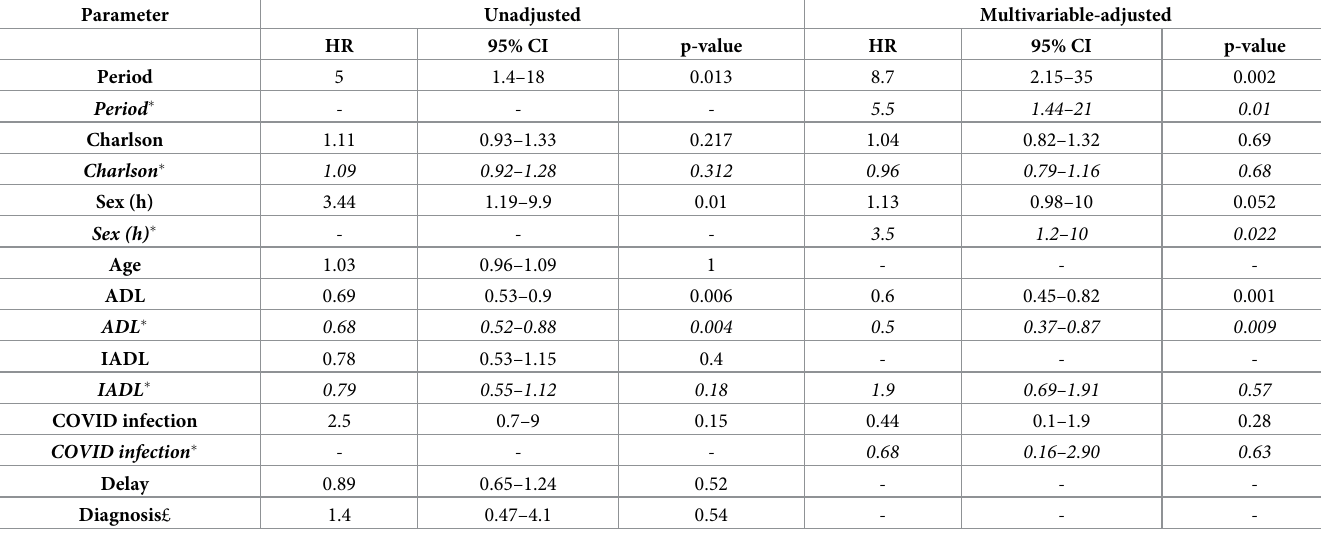
Parameters with a p-value less than 0.2 in the unadjusted analysis were included in the multivariable Cox’s PH regression. £ diagnosis either AO31A or AO31B fracture. � results after Multivariate Imputation by Chained Equation (MICE)